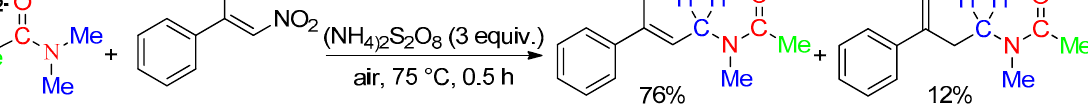
Scheme 39. Cross-coupling of α , β -unsaturated acids, vinyl sulfones, ((phenylethynyl)sulfonyl)benzene and β -nitrostyrenes.